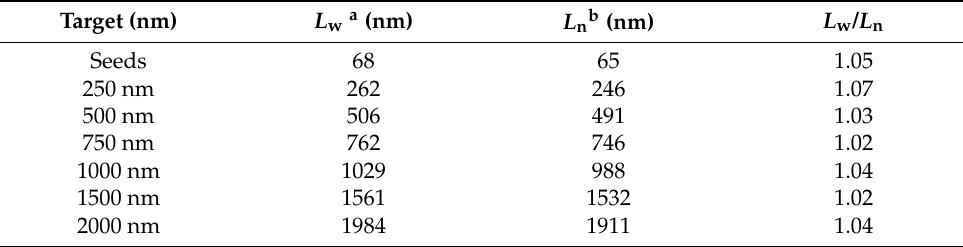
Table 1. Length dispersity of cylinders formed by epitaxial growth of PCL 50 - b -PMMA 20 - b -PDMA 200 cylindrical